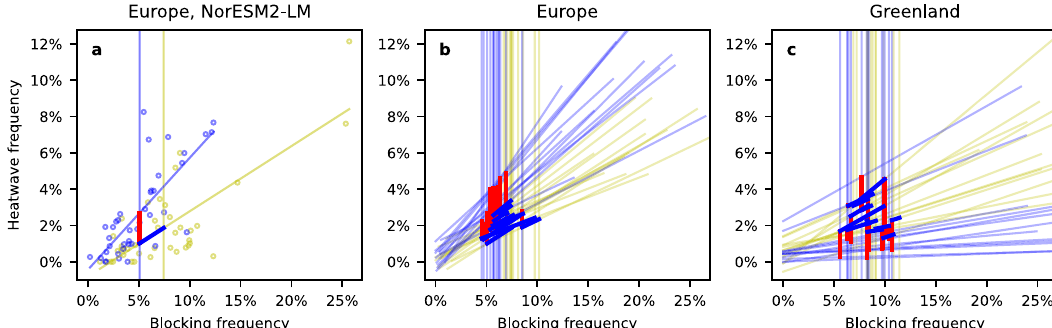
Fig. 5 Sole effect of blocking decrease dominated by the change in heatwave – blocking relation. a Scatter plot of heatwave frequency versus optimized blocking index, both averaged over Europe (land points in 40°N – 60°N, 10°W – 30°E) for historical (1966 – 2005, yellow) and SSP585 (2060 – 2099, blue), in the NorESM2-LM model. Also shown are the mean blocking frequencies (vertical lines) and linear regression lines. Bold line segments show how heatwave changes are contributed by blocking changes (blue) and heatwave – blocking relation change (red). b , c As a , but for 13 CMIP6 models over Europe ( b ) and Greenland ( c , land points in 60°N – 84°N, 52°W – 27°W). Individual plots for 13 models are in Supplementary Figs. 1 and 2.